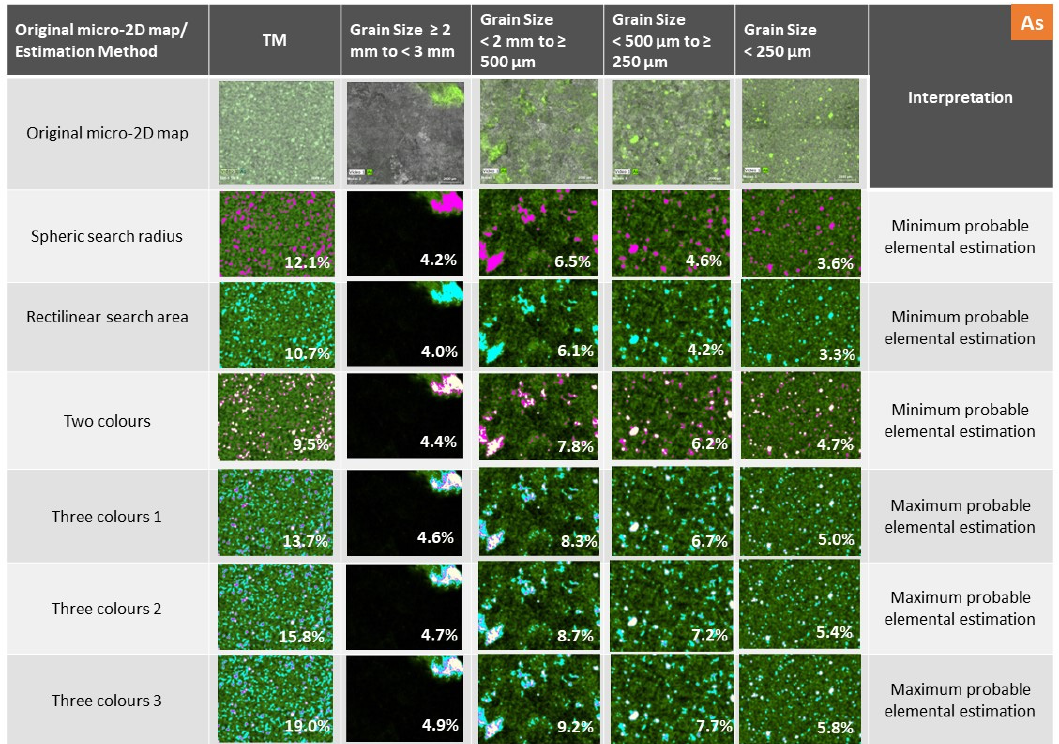
Figure A4. Minimum and maximum probable elemental occurrence in µ-XRF 2D map (percentage of area %) for Zn.